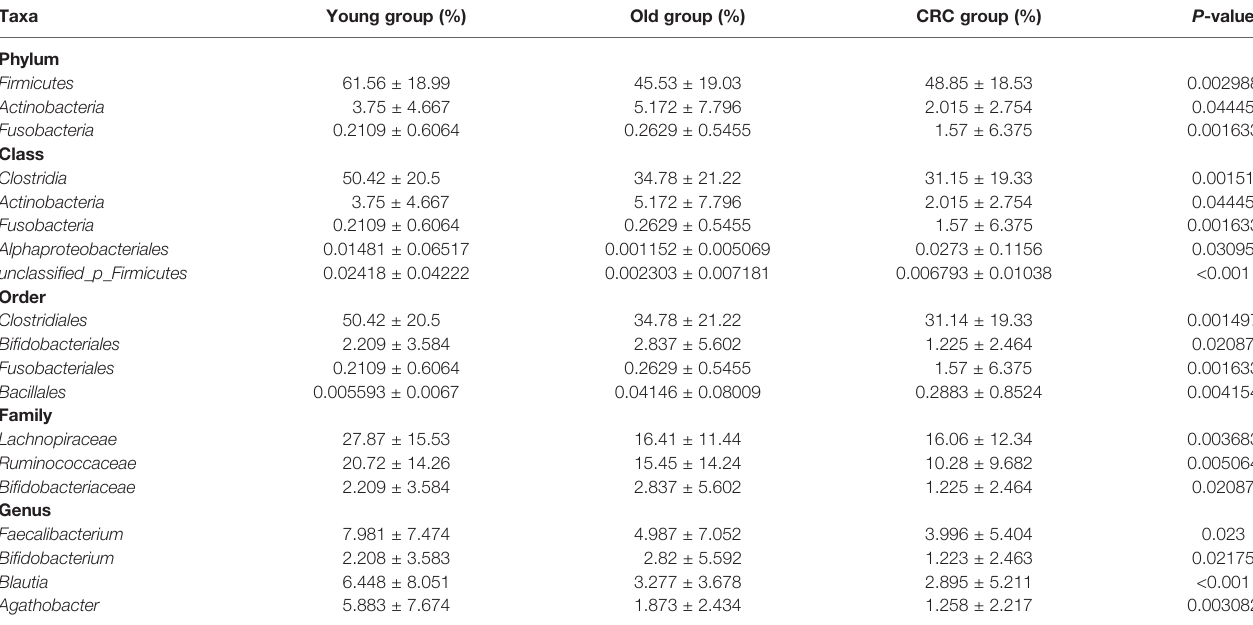
TABLE 2 | Taxa differentially represented in the gut microbiomes of the three groups. Taxa Young group